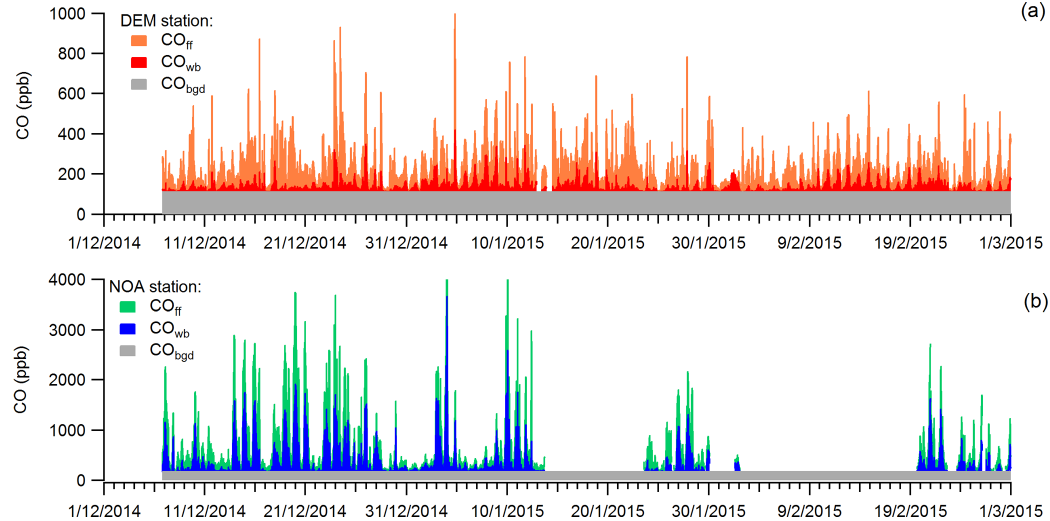
Figure 9. Time series of the calculated CO ff , CO wb and CO bgd concentration at (a) DEM and (b) NOA